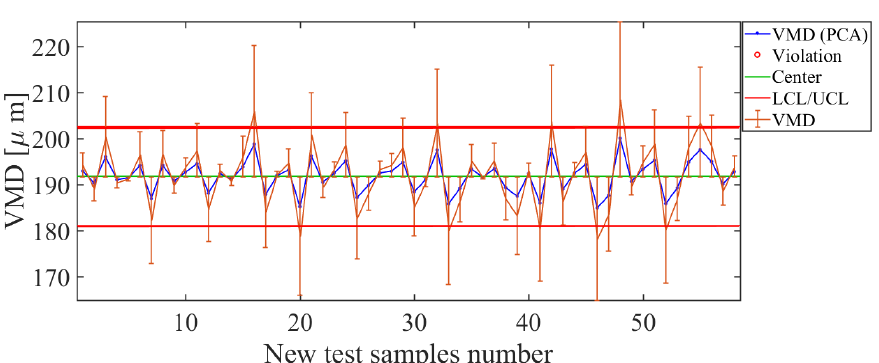
Figure 13. Soft-sensor response (control chart and error bars) for the volumetric median diameter (VMD) descriptor. For values in the range 180 µ m < VMD < 200 µ m, suitable estimates are provided.